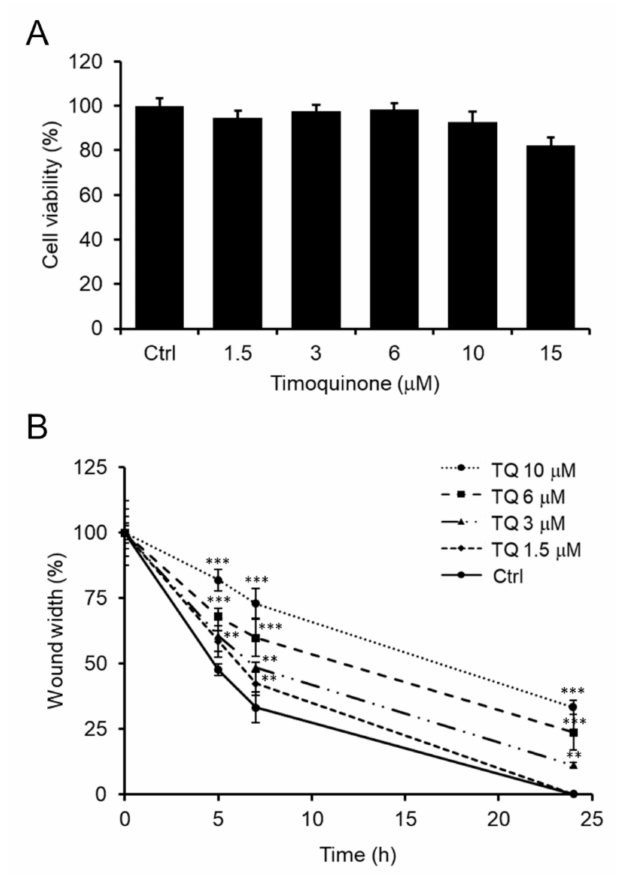
Figure 6. Effect of TQ on SH-SY5Y cell viability and migration. ( A ) MTT assay on cells treated with various TQ concentrations for 24 h under starvation condition. Untreated cells were used as control. Data are reported as percentage values compared to untreated control cells and expressed as the mean ±